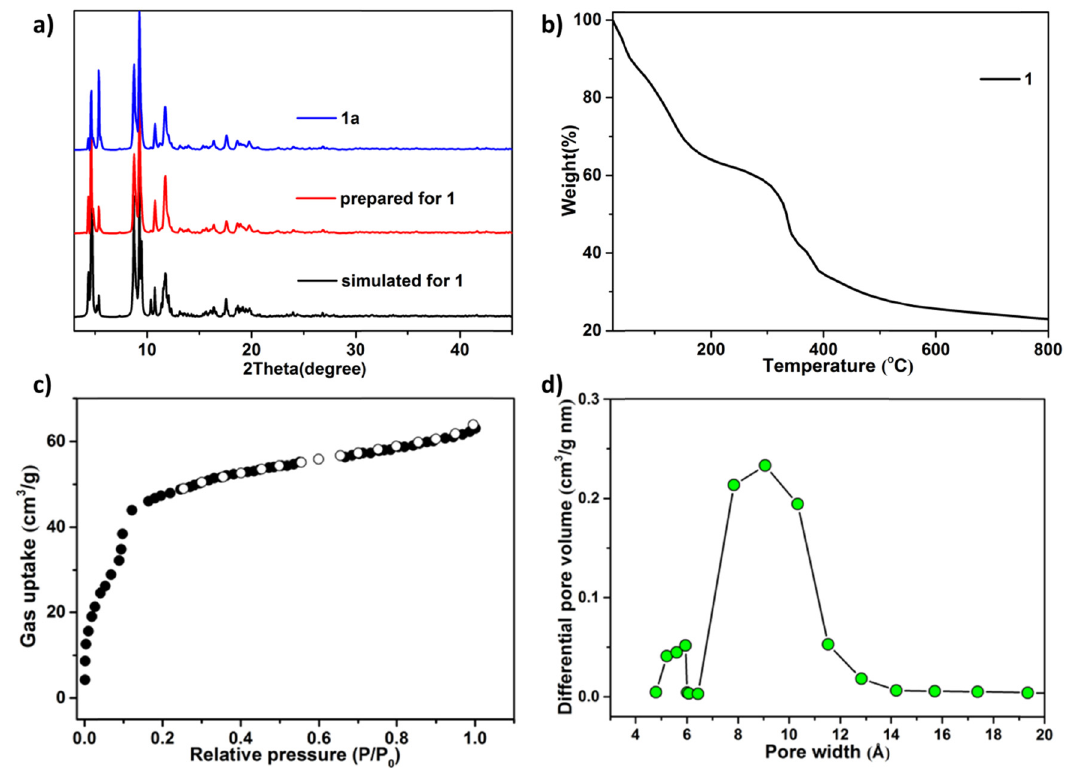
Figure 2: ( a ) The complex 1 ’ s patterns of PXRD; ( b ) the curve of TGA for the complex 1 ; ( c ) the N 2 adsorption curve for the 1a at 77 K; ( d ) the distribution of pore size for the 1a .